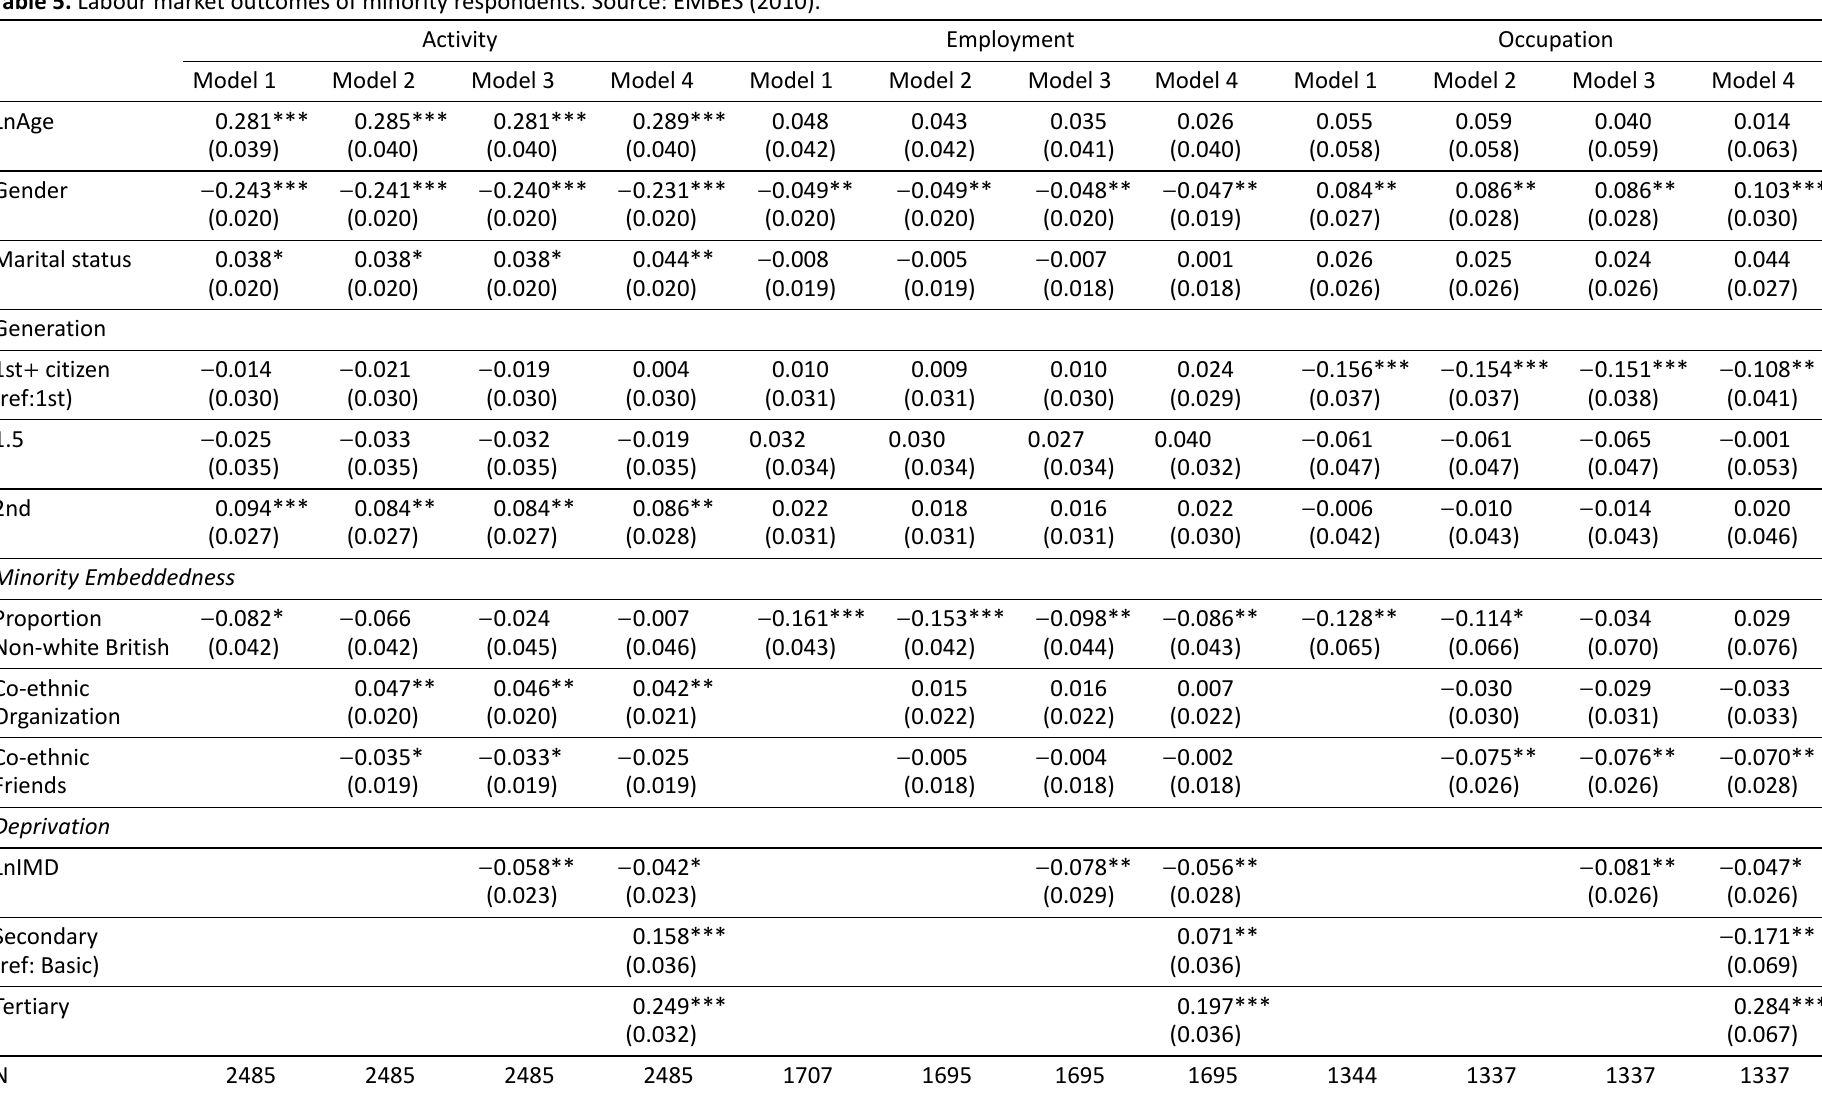
Table 5. Labour market outcomes of minority respondents. Source: EMBES